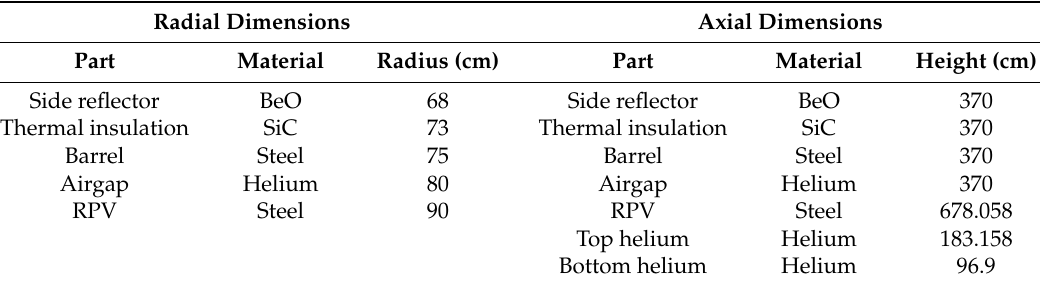
Table A1. Left: Radial dimensions and Right: Axial dimensions.